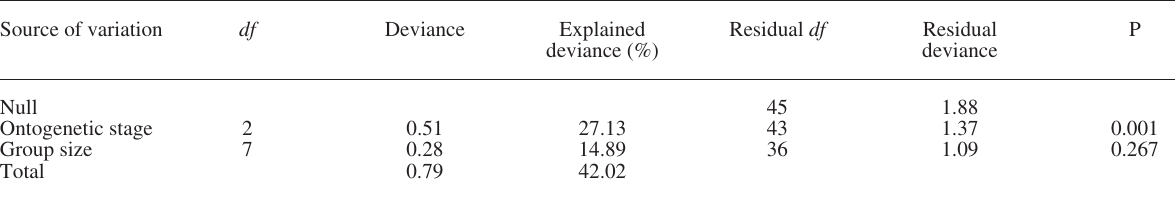
Table 3. – analysis of deviance table for the general linear model fitted to residence persistence data.